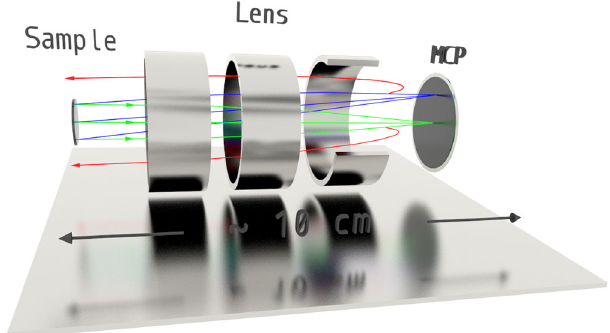
Fig. 2 Simple ARPES. Schematics of the method is shown. Electrons originate at the sample surface. Green rays correspond to normal emission. Blue rays represent electrons emitted at 10° angle in the vertical plane. Red rays are the electrons having lower kinetic energies from both beams, de fl ected by the retarding fi eld. Three cylinders represent the electron lens. MCP is the